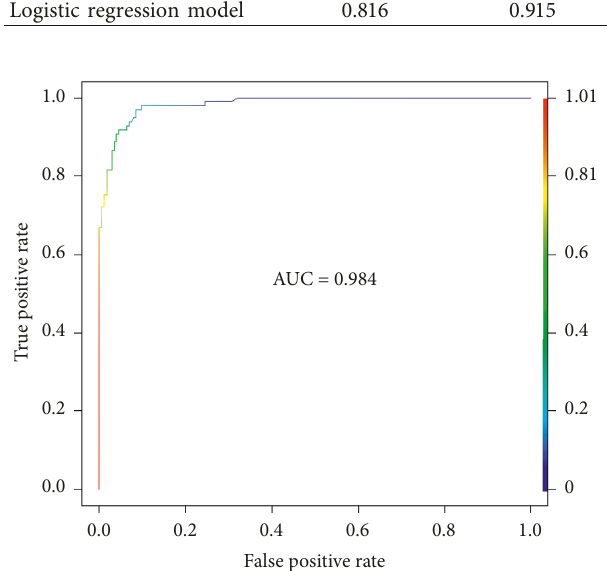
Figure 4: ROC curve based on the logistic prediction model.